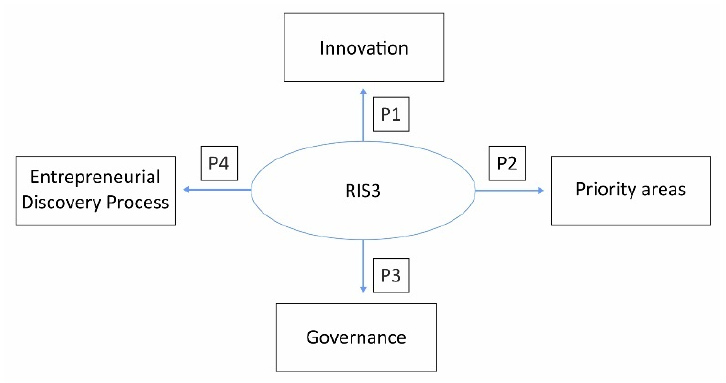
Figure 1. Research